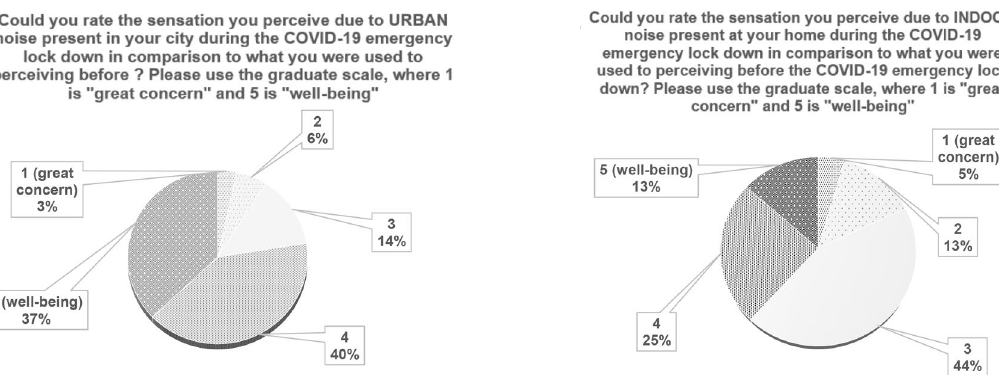
Figure 11. International results: comparison between urban and home variation